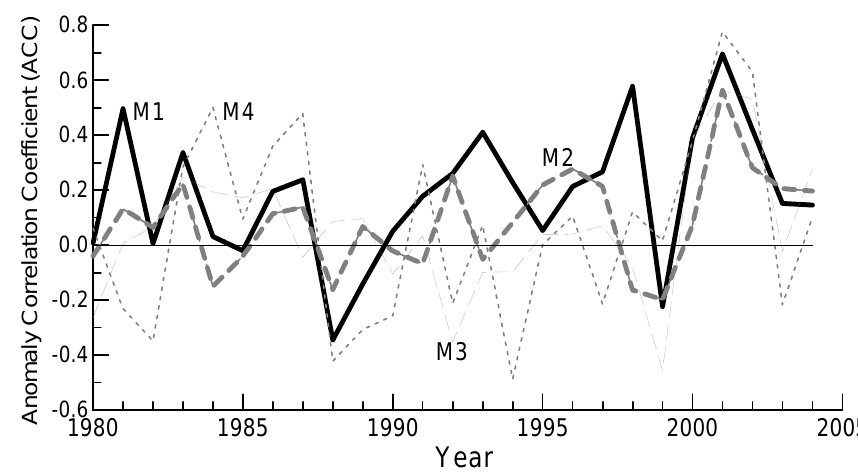
Fig. 1. Comparison of yearly ACC forecasted by the 4 models (M1: thick solid, M2: thick dashes, M3: thin dashes, M4: thin dots).